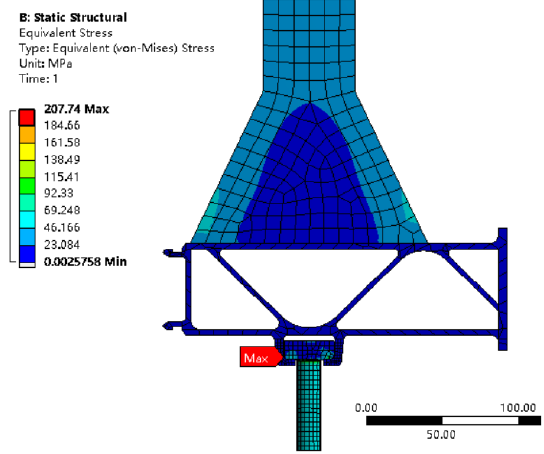
Figure 6. Overall stress distribution diagram.